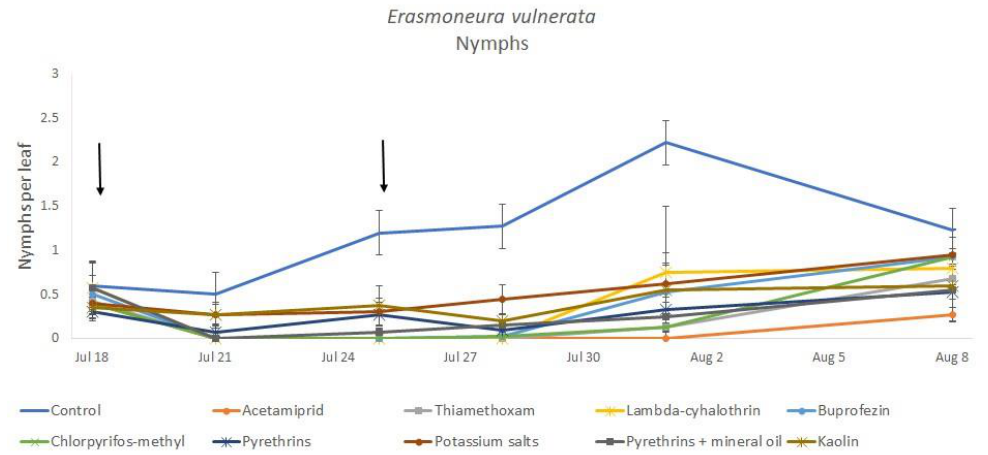
Figure 1. Dynamics of Erasmoneura vulnerata nymphs (mean ± std. err.) in the 2017 trial. Insecticides were applied one (first arrow) or two times (second arrow, see Materials and Methods section).